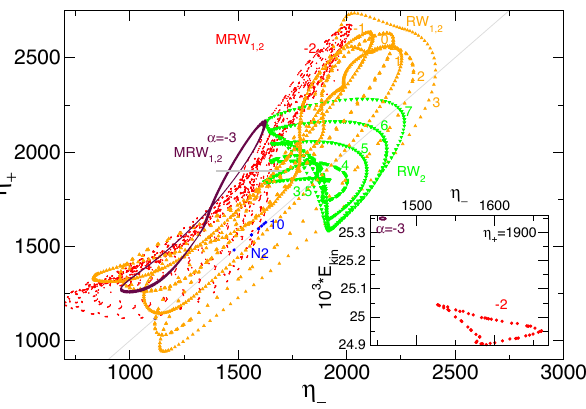
Figure 4. Phase space for rotating flow states. Phase portraits of RW and MRW rotating flow states for α , as ) . The inset shows the corresponding two-dimensional Poincaré section, ( E kin , η , η indicated on (η − + η ) ). Numbers in the inset identify corresponding strengths of radial 1900 (horizontal gray line in (η , η + = − + flow α